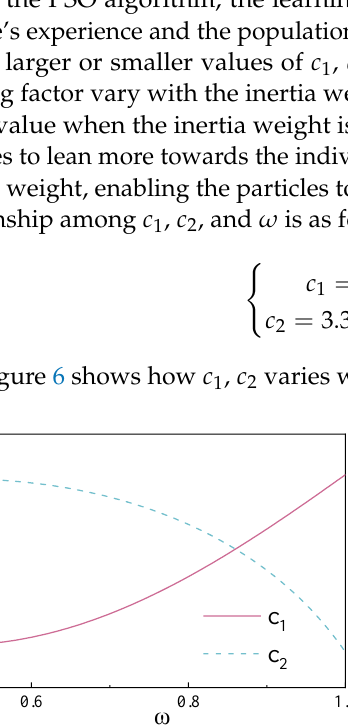
Figure 6. Evolution of